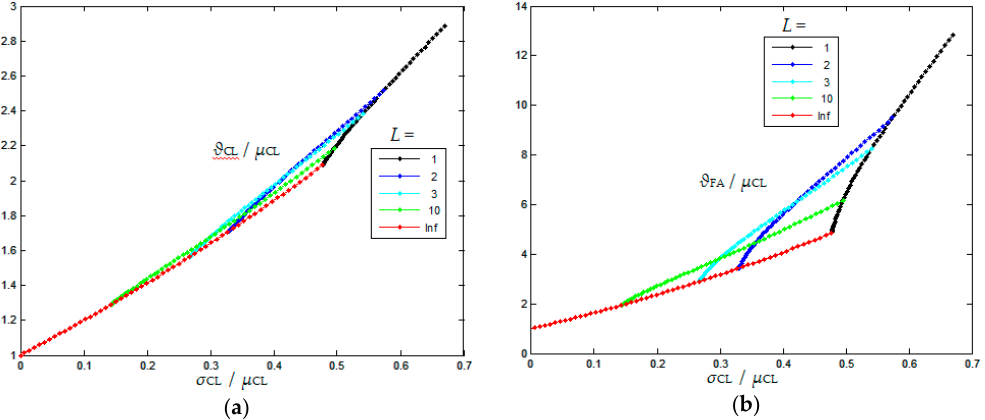
Figure 1. Numerical calculations of variables as a function of 1/ √ ν . ( a ) σ / µ ( black /upper) and σ CL / µ CL ( red /lower). ( b ) ϑ FA / µ CL ( green /highest), ϑ FA / µ ( blue /second), ϑ CL / µ CL ( red /third), ϑ CL / µ (black/lowest).